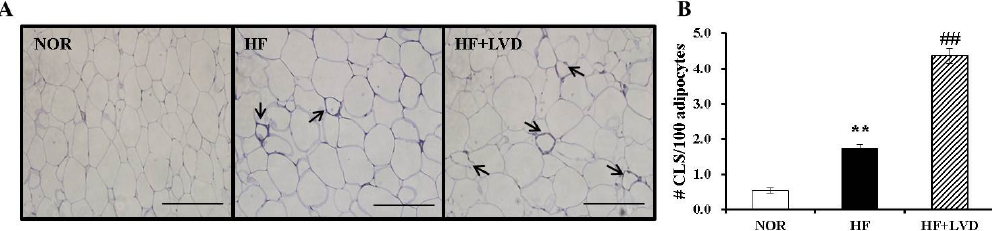
Figure 4. Vitamin D insufficiency increases macrophage infiltration in adipose tissue. ( A ) Macrophage marker, F4/80 immunohistochemistry of epididymal adipose tissue (scale bar, 50 μ m; magnification, 40×); the black arrows indicate a CLS; ( B ) Number of CLS was quantified from multiple histologic sections and expressed as the mean ± SEM. ** p < 0.01 compared to NOR. ## p < 0.01 compared to HF. NOR, 10% fat diet with 1000 IU vitamin D ( n = 9); HF, 45% fat diet with 1000 IU vitamin D ( n = 7); HF+LVD, 45% fat diet containing 25 IU vitamin D ( n = 7).